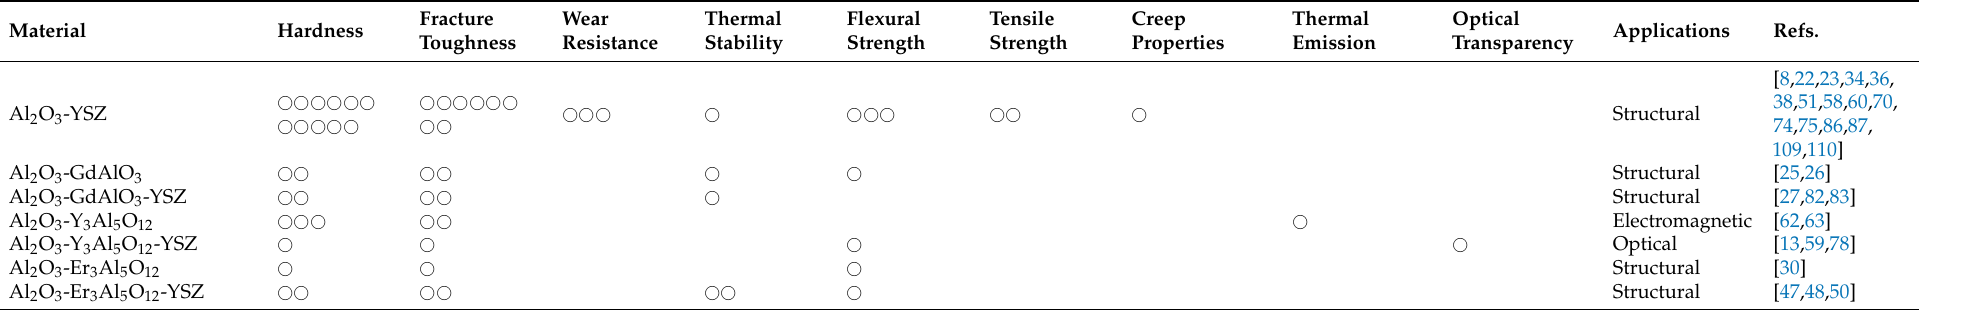
Table 1. Summary of the published work on the properties of alumina-based nanoeutectic ceramics and their applications.